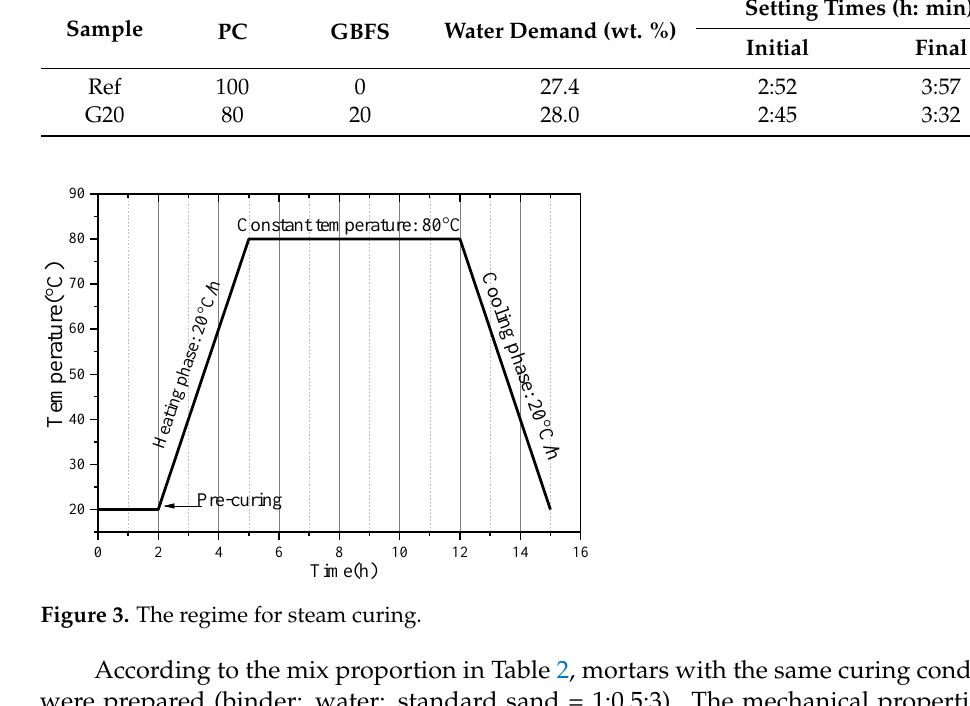
Figure 3. The regime for steam curing.